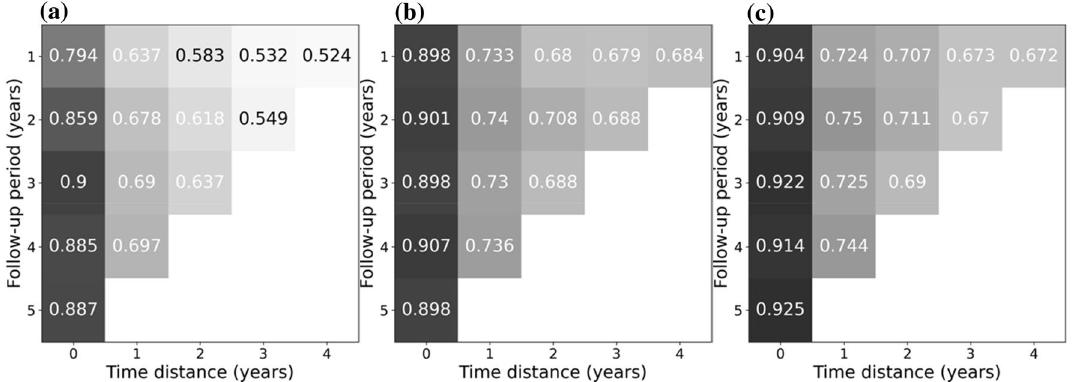
Figure 3. Sensitivity for predicting death using Logistic Regression ( a ), Random Forests ( b ) and Extreme Gradient Boosting ( c ). Models built on different follow-up periods (from 1 to 5 years) in which covariates may have occurred, and used different time distances (time between exposure and event [death]).